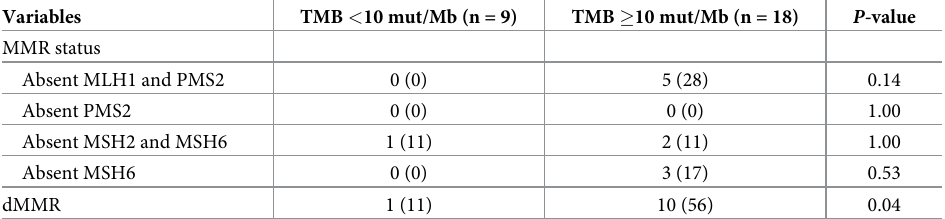
Table 3. Outcome of immunohistochemistry analysis of small-bowel cancer lesions with high TMB and low